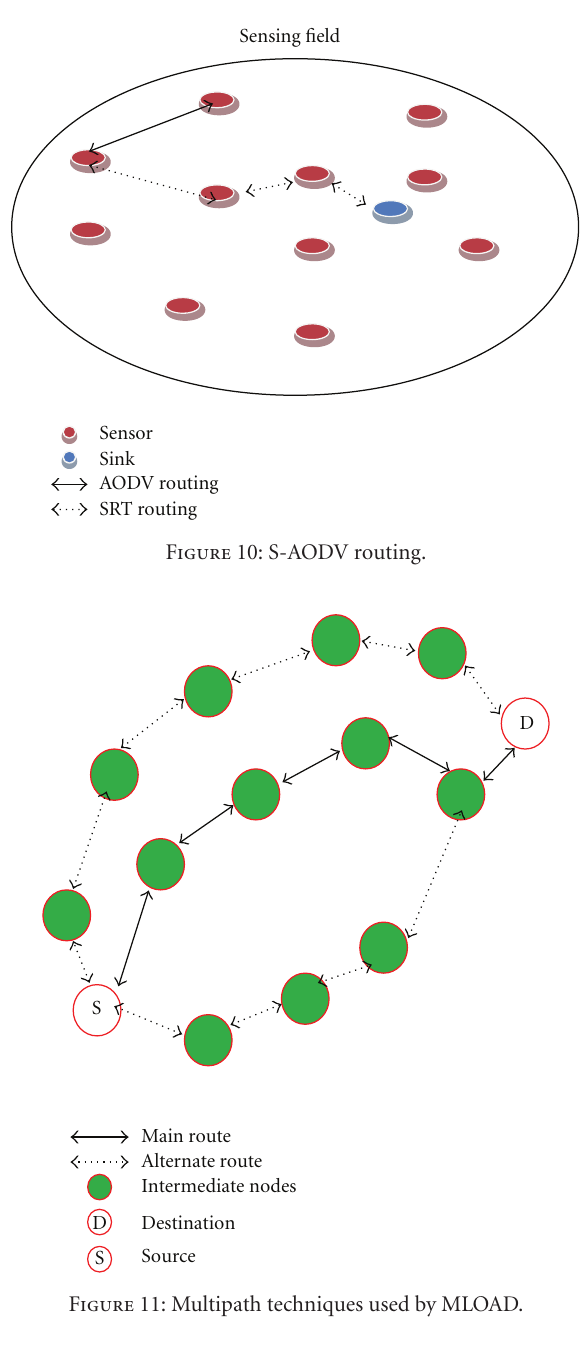
Figure 11: Multipath techniques used by